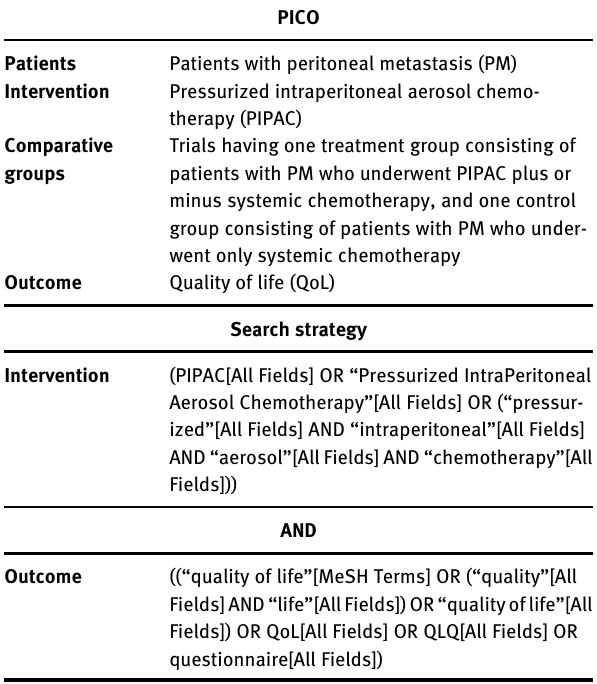
Table  : PICO [  ] and search